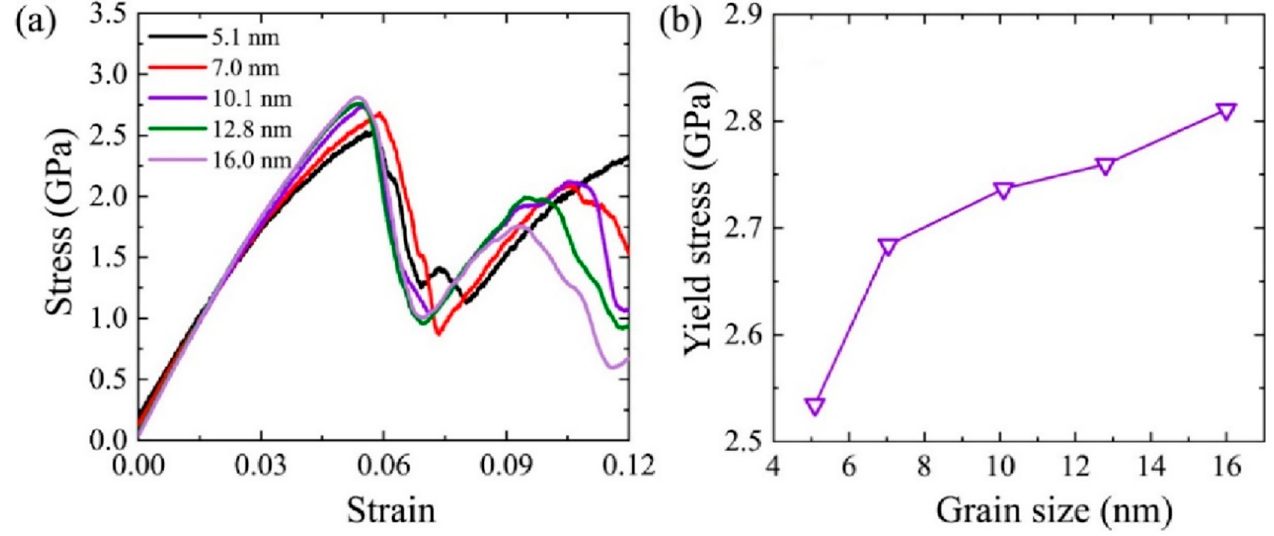
Figure 13. ( a ) Stress-strain curves of polycrystalline Al-Mg alloys with various average grain sizes; ( b ) Relationships between yield stress and grain size at 300 K. ( b ) Relationships between yield stress and grain size at 300